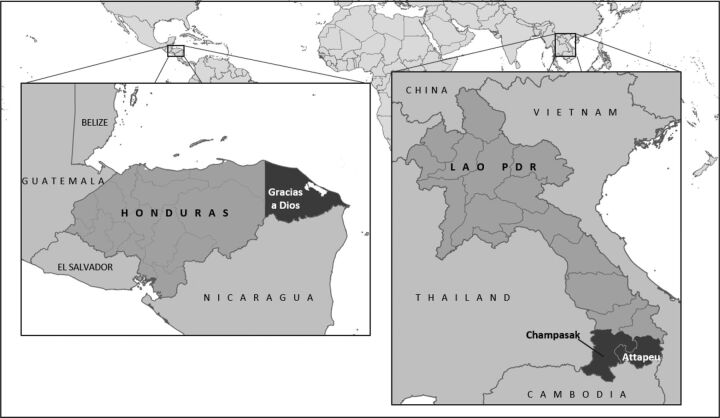
Sites in Gracias a Dios in Honduras and 2 Provinces in Lao PDR Selected for Data CollectionAbbreviation: PDR, People's Democratic Republic.